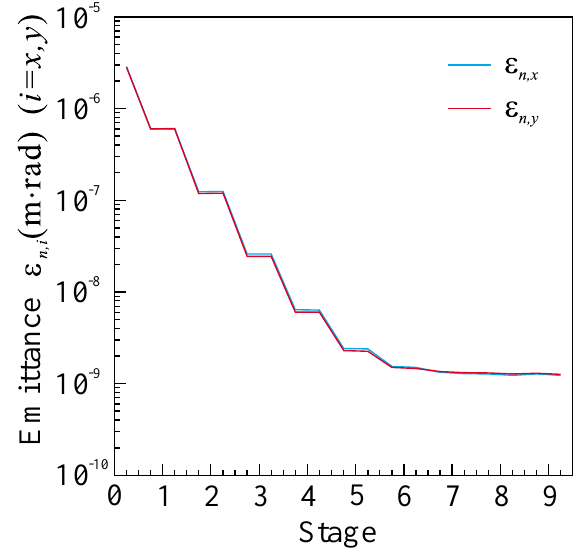
FIG. 2. (Color) The transverse sizes of the electron beams.